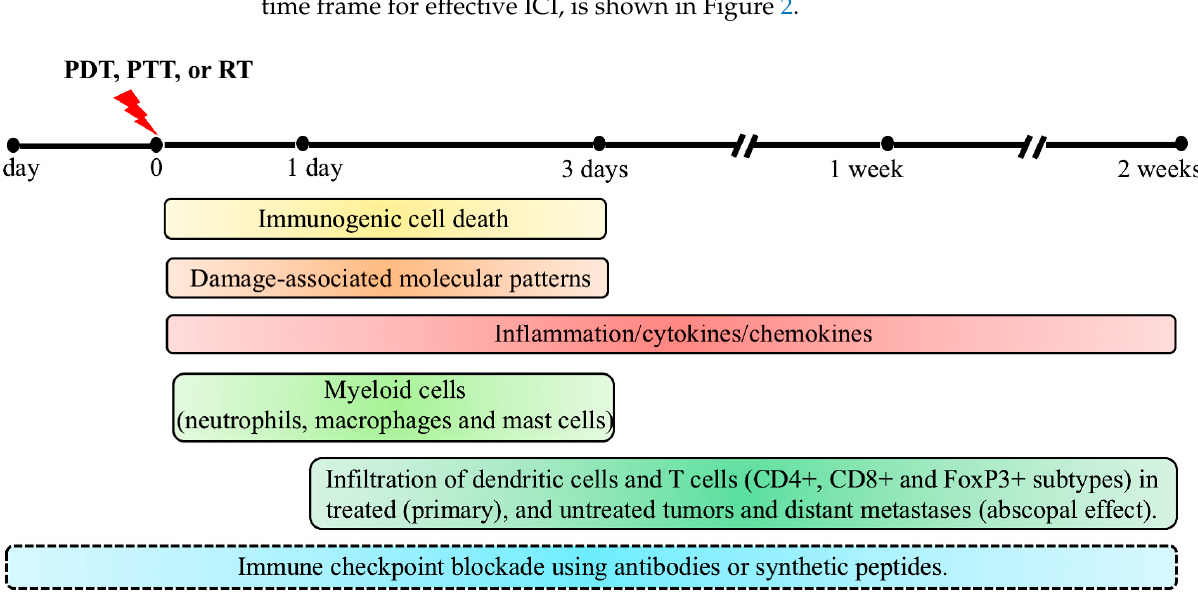
is still under exploration. Although the timeline and immunological events discussed above were observed in PDT-treated mouse models, similar mechanisms of anti-tumor immunity have also been reported in pre-clinical studies using PTT and RT, as described in the